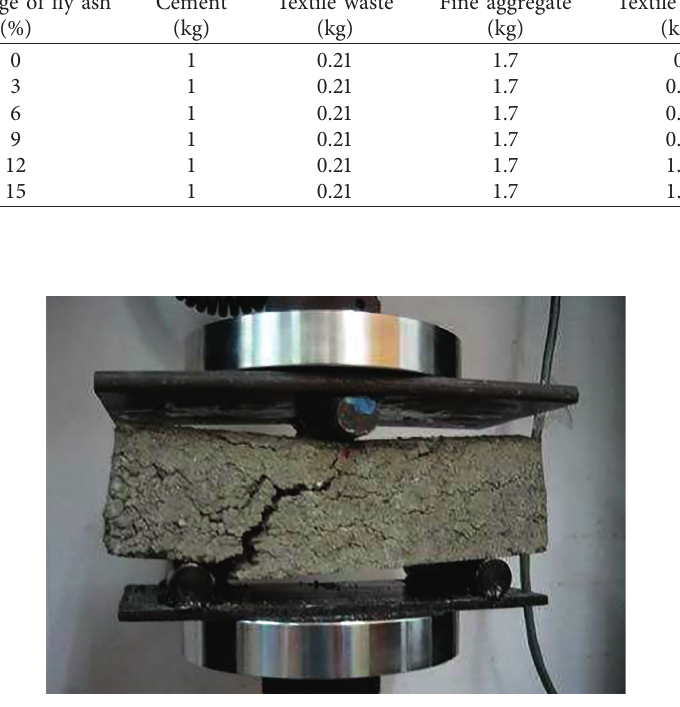
Figure 1: Experimentation on three-point load flexural strength.